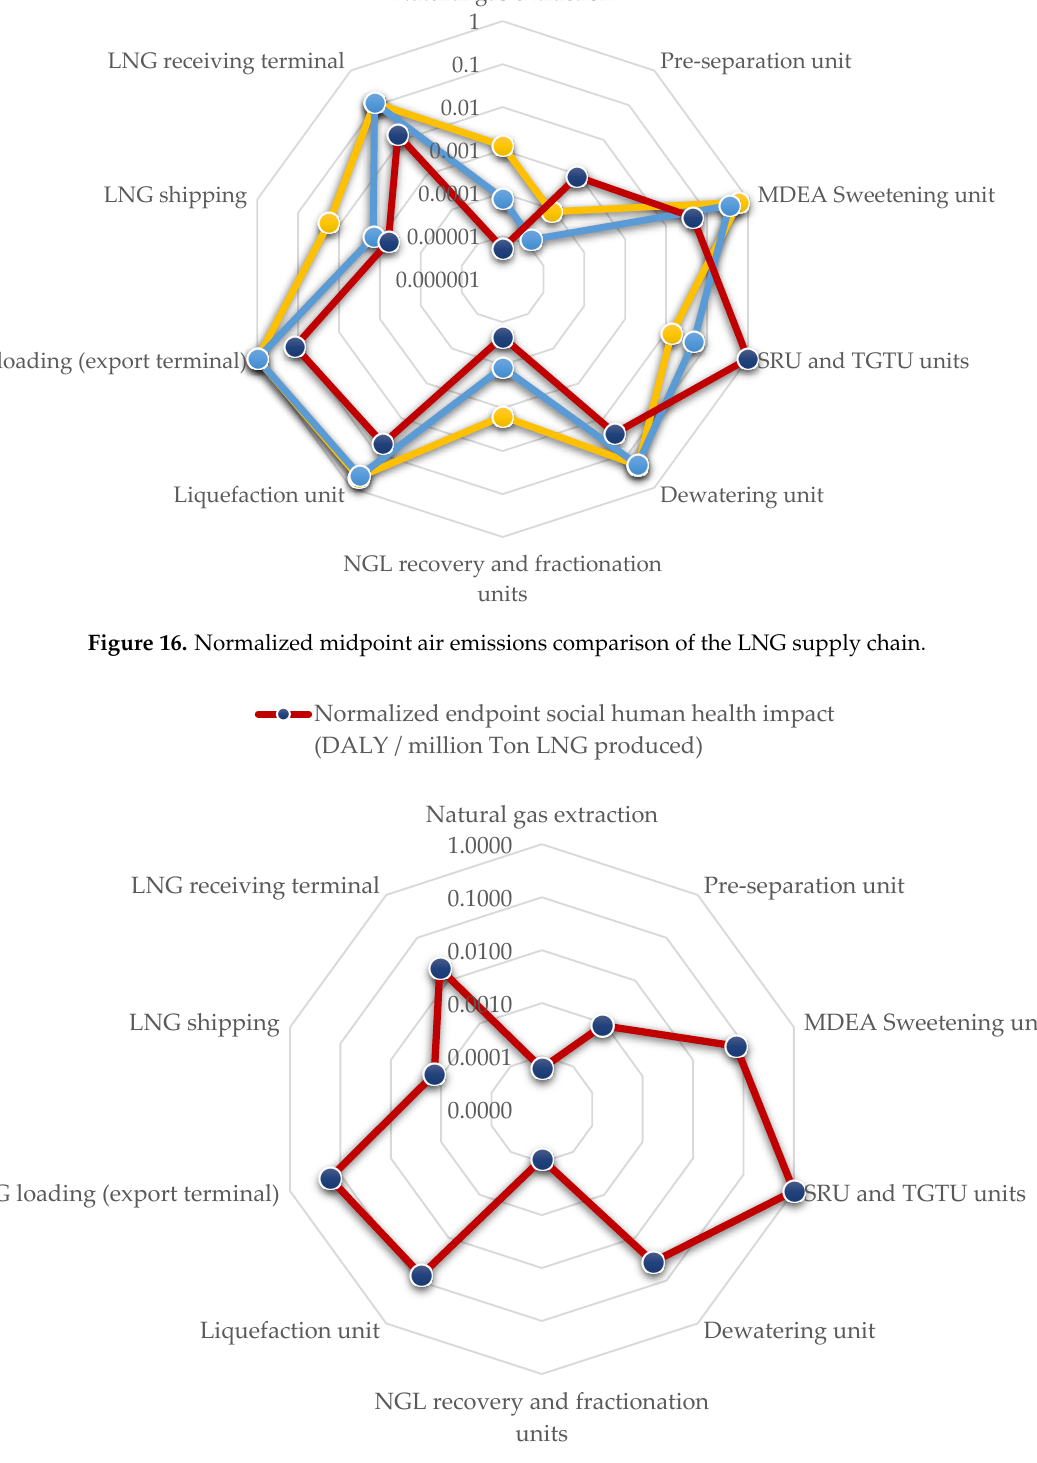
Figure 17. Normalized endpoint social human health impact over the LNG supply chain. The results indicate SRU and TGTU units as the highest stage for social human